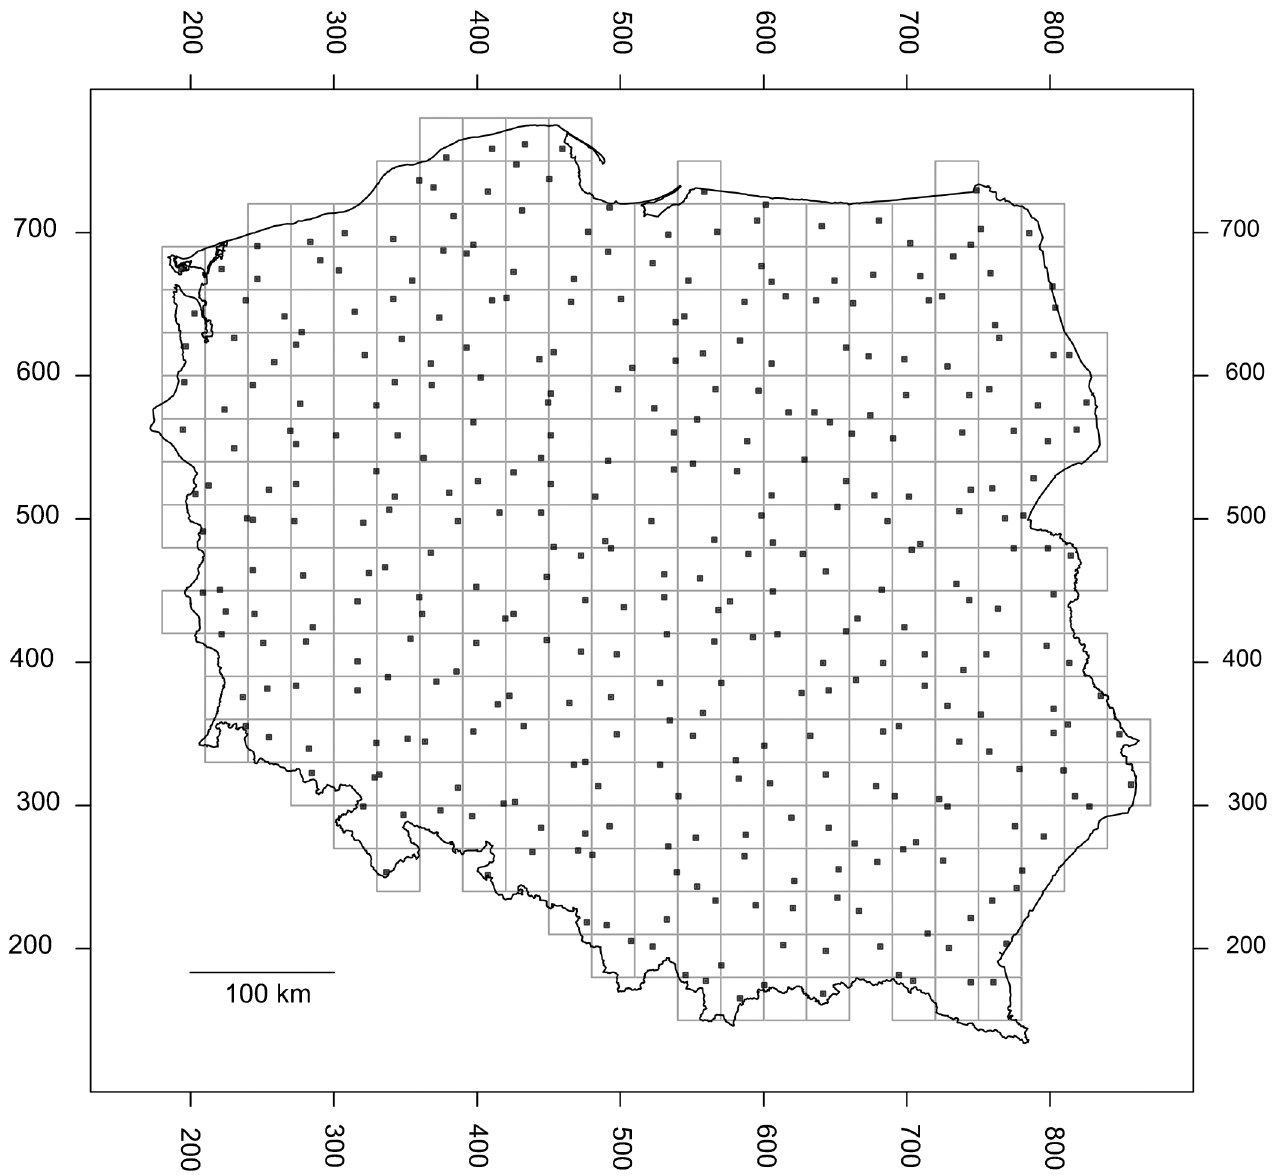
Fig 1. The area of Poland divided to 367 strata. Smaller squares were selected randomly within agrarian landscapes for plant sampling.